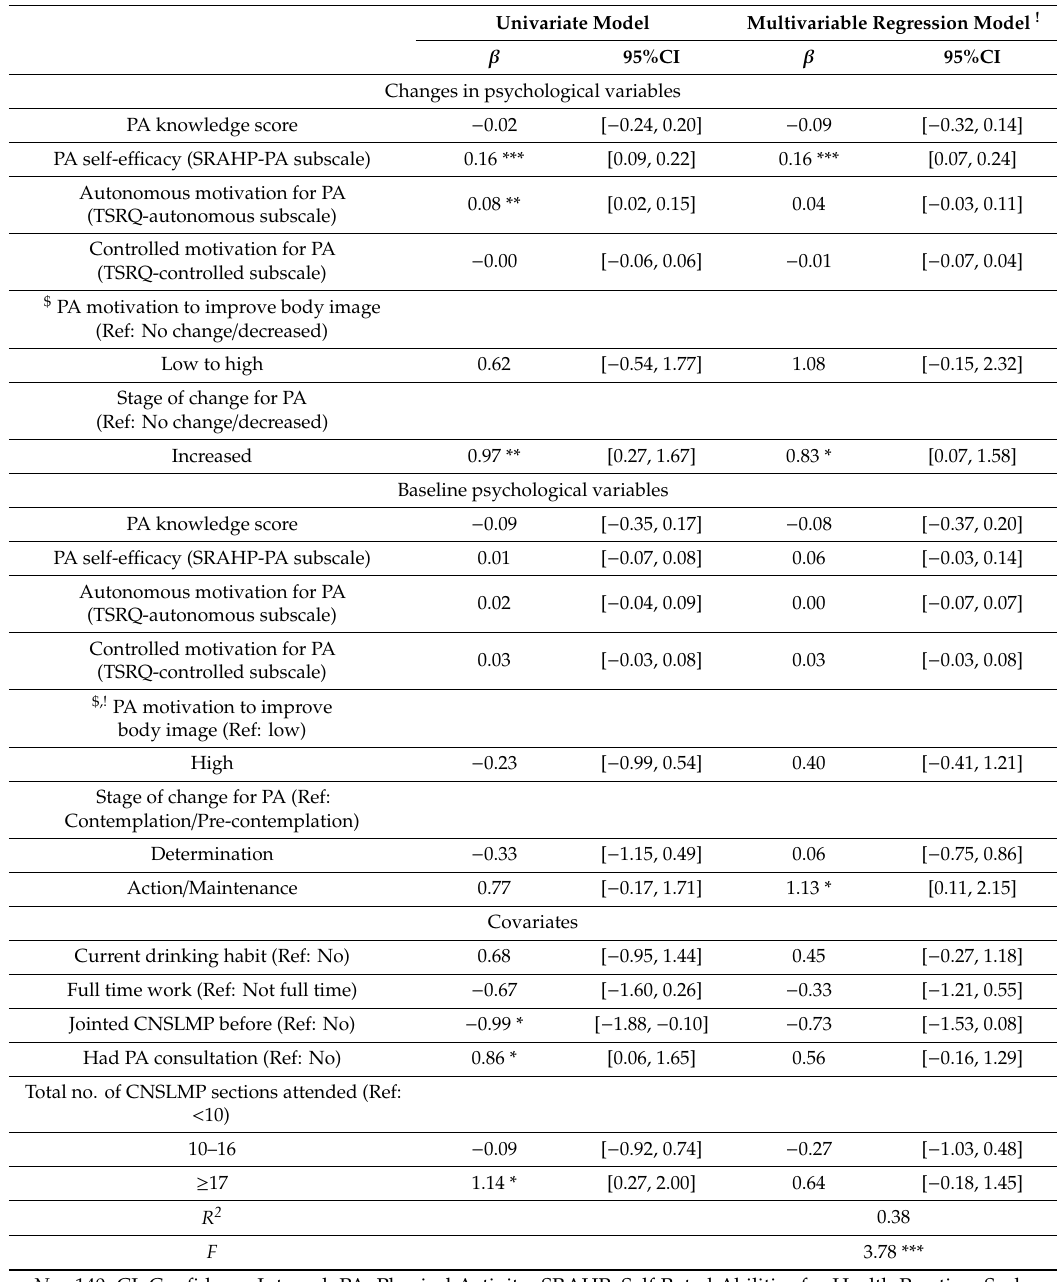
Table 4. Results of univariate and multivariable regression analyses for PA adherence